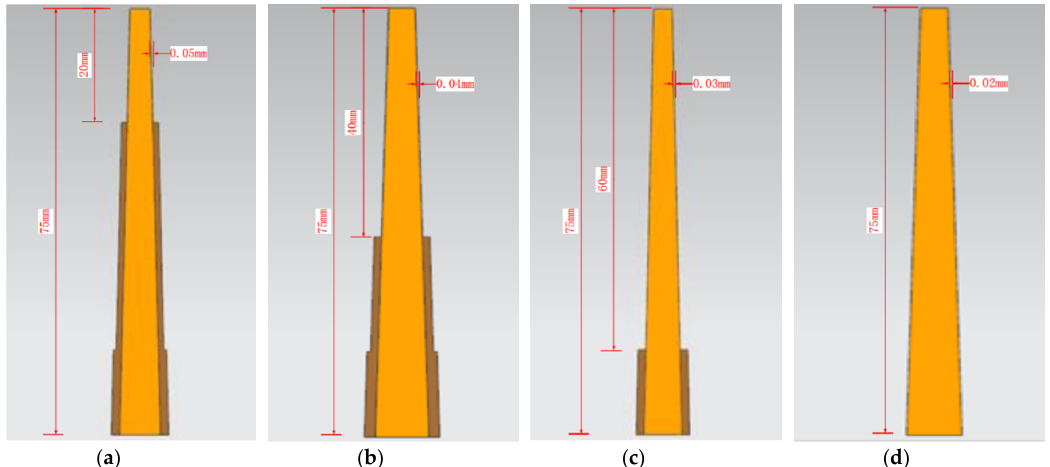
Figure 7. Semi-finishing and finishing machining: ( a ) first layer; ( b ) second layer; ( c ) third layer; ( d ) fourth layer.